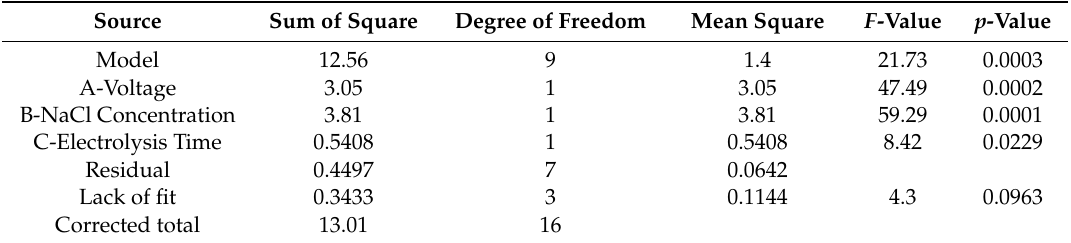
Table 8. Analysis of variance for the developed response surface quadratic model for pH of